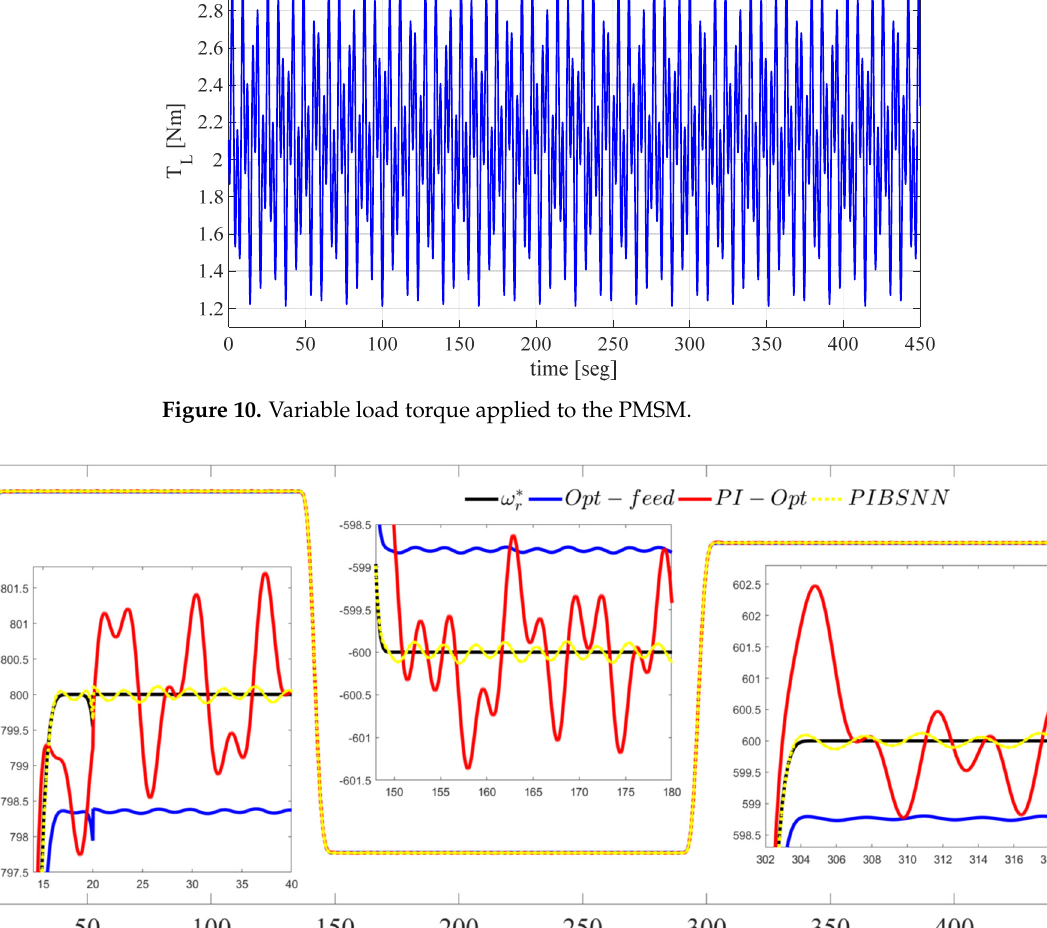
Figure 12. Transient response of currents in the reference frame dq and speed error for the PMSM subjected to abrupt changes of load torque disturbance; ( a ) Opt.-feed; ( b ) PI-Op; and ( c ) PIBSNN.